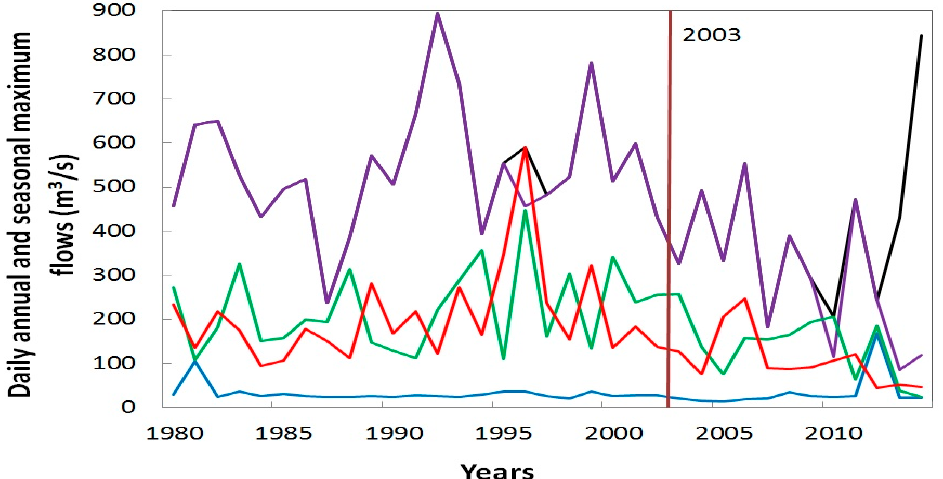
Figure 3. Temporal variability of annual and seasonal daily maximum flows before and after construction of the diversion dam in 2003 (vertical line). Annual = black curve; winter: blue curve; spring = purple curve; summer = green curve; fall = red curve.